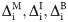
Allometric scaling parameters for mass and metabolism.Plots of (a) estimated mass-scaling exponents and predicted values (grey-dashed lines) for mass (b = 3.0), individual metabolic rate (γ = 0.75) and mass-specific metabolic rate (α = -0.25), and (b-d) species-specific normalizing coefficient modifiers (ΔiM,ΔiI,ΔiB). Letters in (b-d) indicate groupings based on 95% confidence intervals. All error bars = ±95% confidence intervals. Red-dashed lines = 0. Echinoid species codes as in Fig 1a.